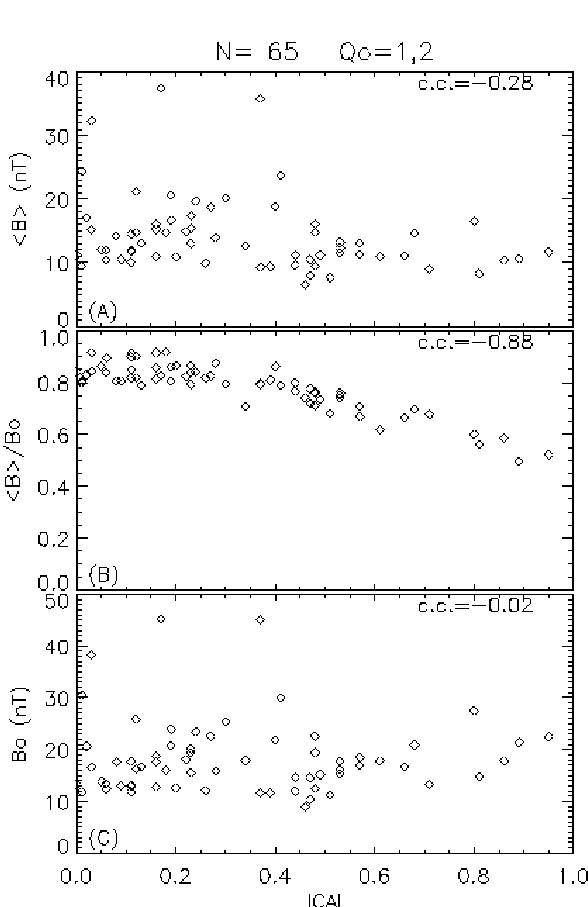
Fig. 4. < | B | > , < | B | > / B O , and B O , in panels (A) , (B) , and (C) , respectively, each plotted against | CA | and all for Q O =1,2 ( N =65). Figure 4. <| B |>, <| B |>/B O , and B O , in panels (A), (B), and (C), respectively, each The linear correlation coefficient (c.c.) for each quantity is shown plotted against |CA| (in %) and all for Q O = 1,2 (N = 65). The linear correlation in its coefficient (c.c.) for each quantity is shown in its panel.